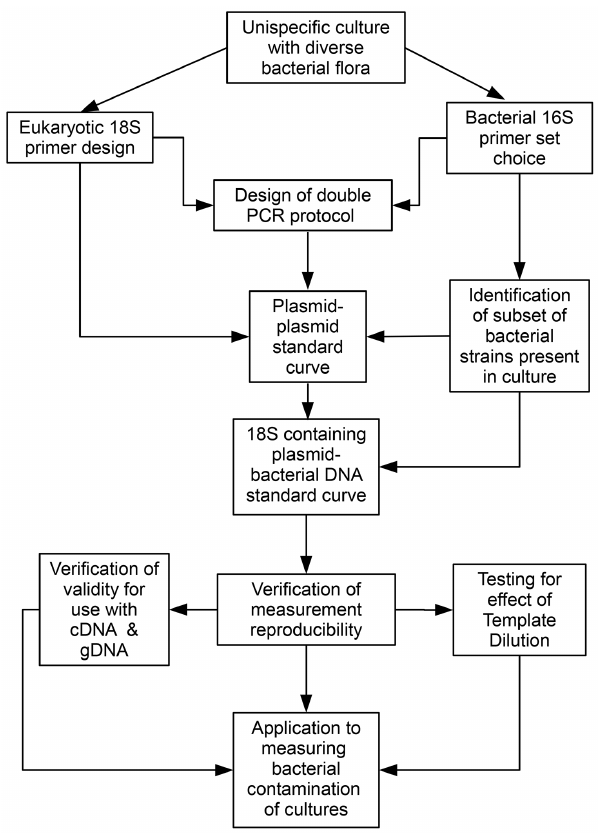
Figure 1. Outline procedure for development of the duplex PCR-based assay. These steps were used to measure the levels of bacterial contamination in nucleic acid extracts from cultures of the loricate choanoflagellates Stephanoeca diplocostata and Diaphanoeca grandis .